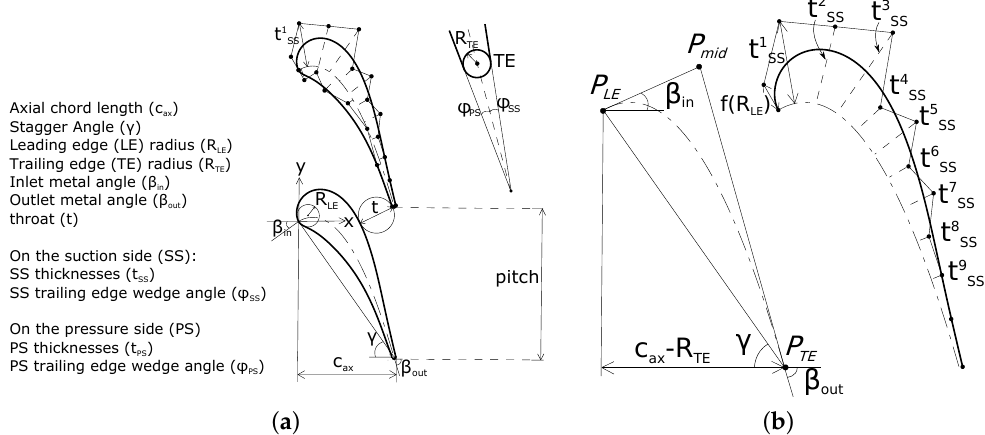
Figure 1. Computer-aided design (CAD)-based parametrization of the turbine cascade. ( a ) Turbine cascade parametrization; ( b ) Construction of the suction side by a B-spline curve